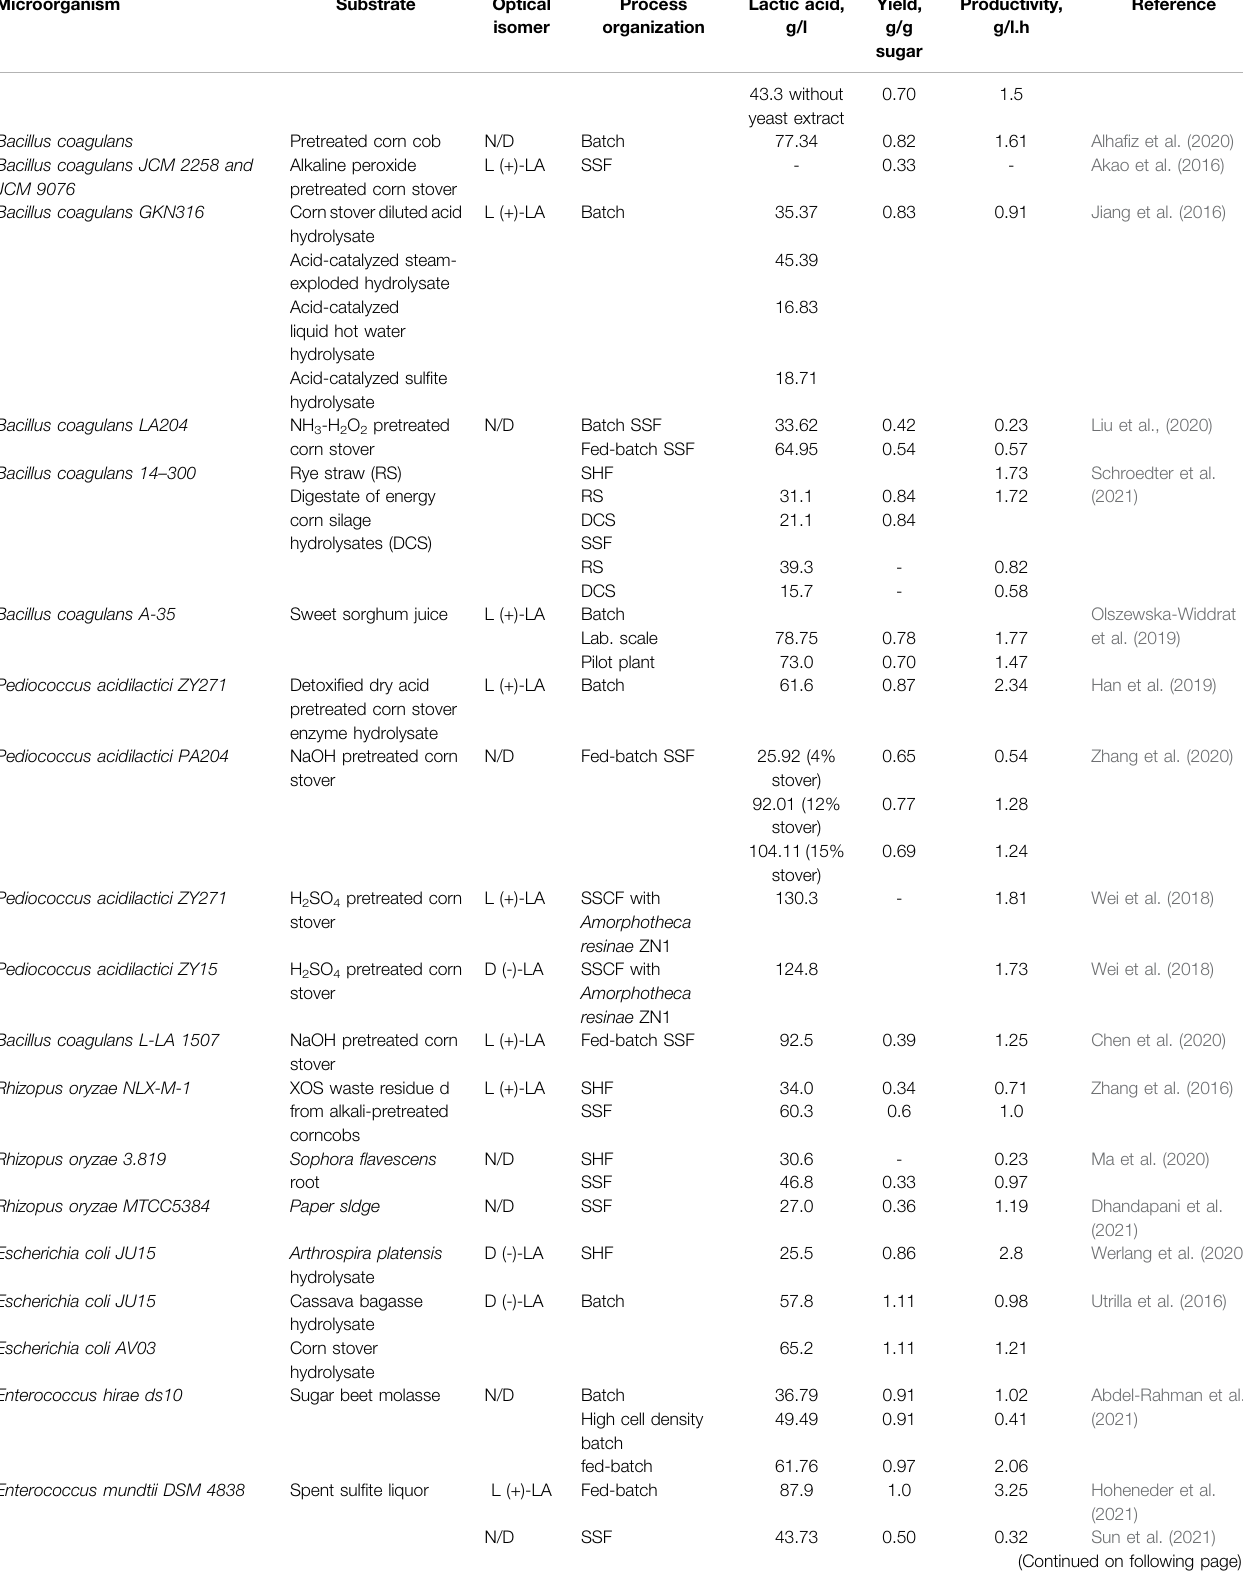
TABLE 4 | ( Continued ) Microorganisms, substrates, and lactic acid yield and productivity from different feedstocks.